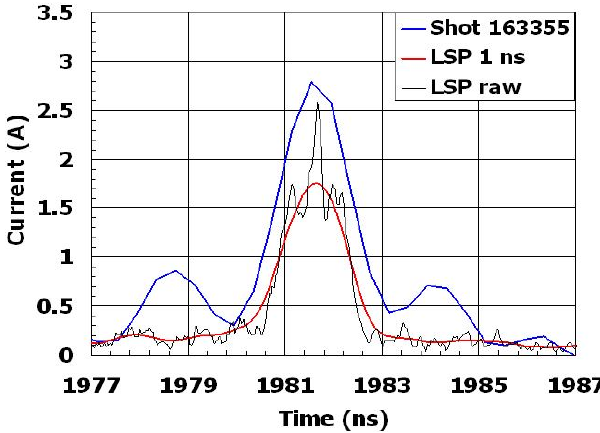
FIG. 7. (Color) The current near compression at z (cid:5) 414 cm is plotted for the measured NDCX (shot 163355) and 2D integrated L SP simulation with a 1-ns Gaussian response and the raw L SP data.